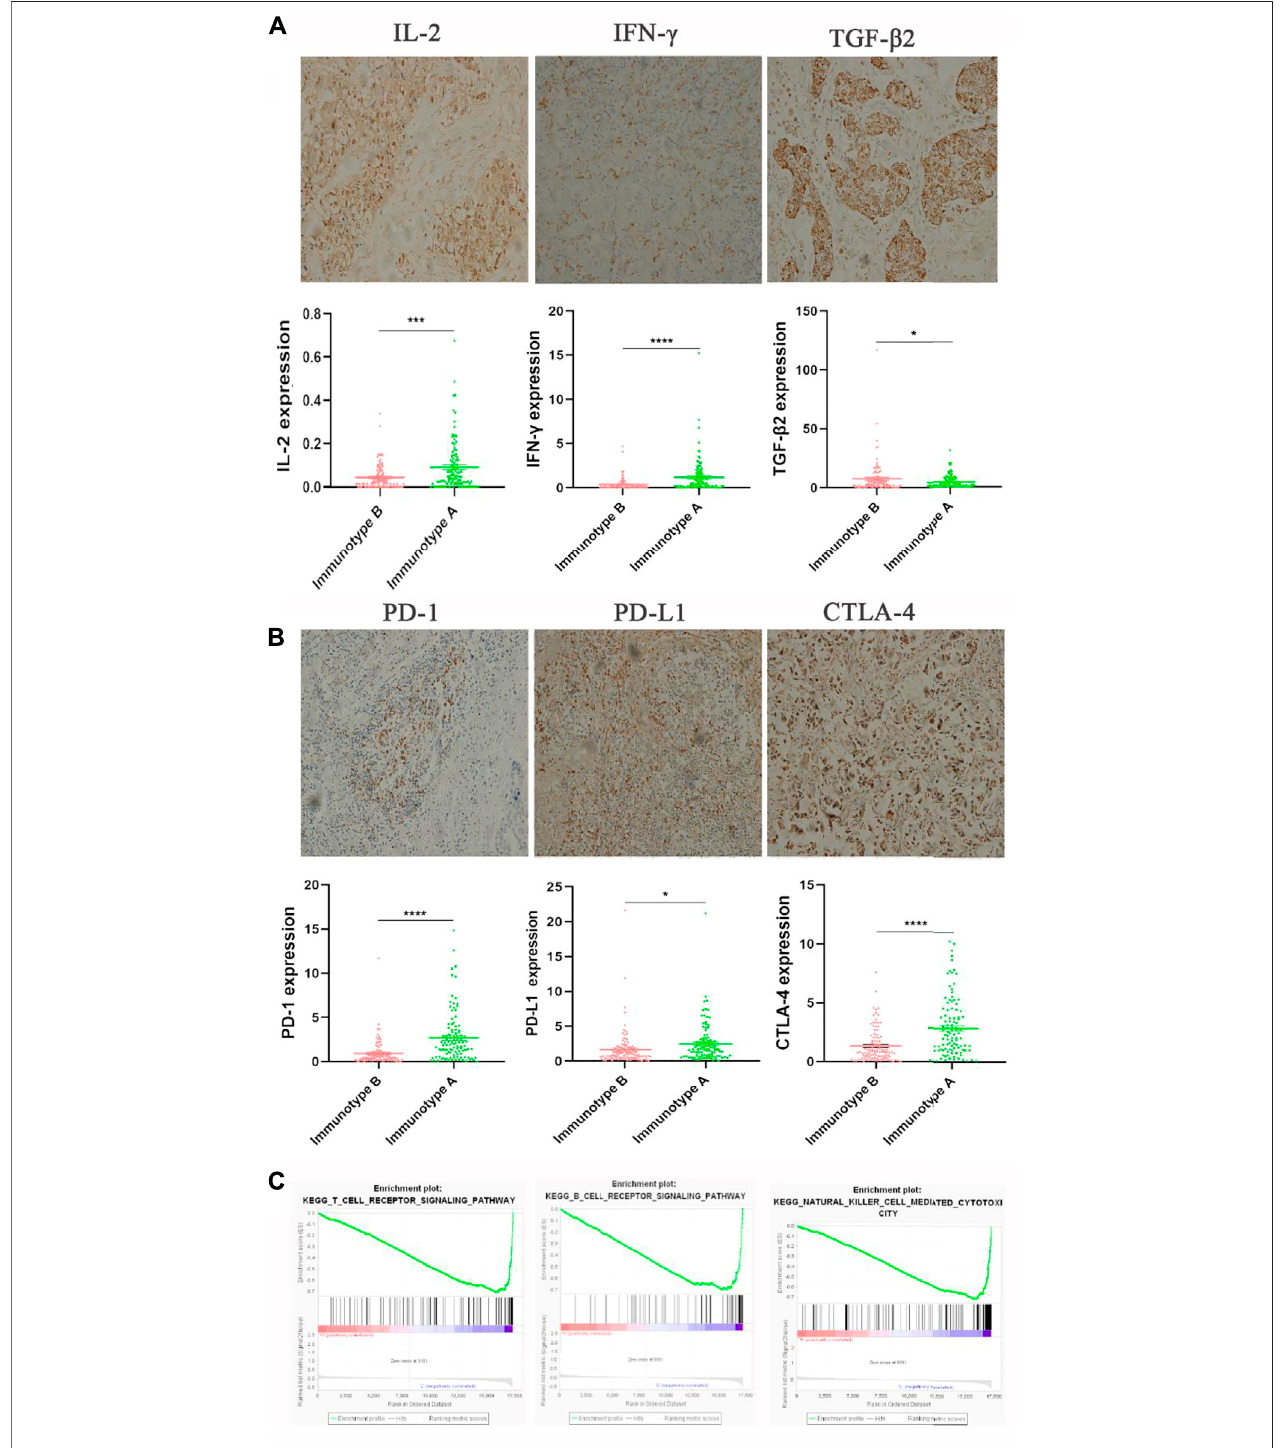
FIGURE6| Theexpressionofimmunomarkersandsignalpathwayofstromalimmunotypes.TherepresentativeimmunohistochemistryimagesofIL-2,IFN- γ ,TGF- β 2 (A) . The associations of immunotype with the immune check-point markers (B) . Three enriched biology pathways related with different stromal immunotypes (C) .